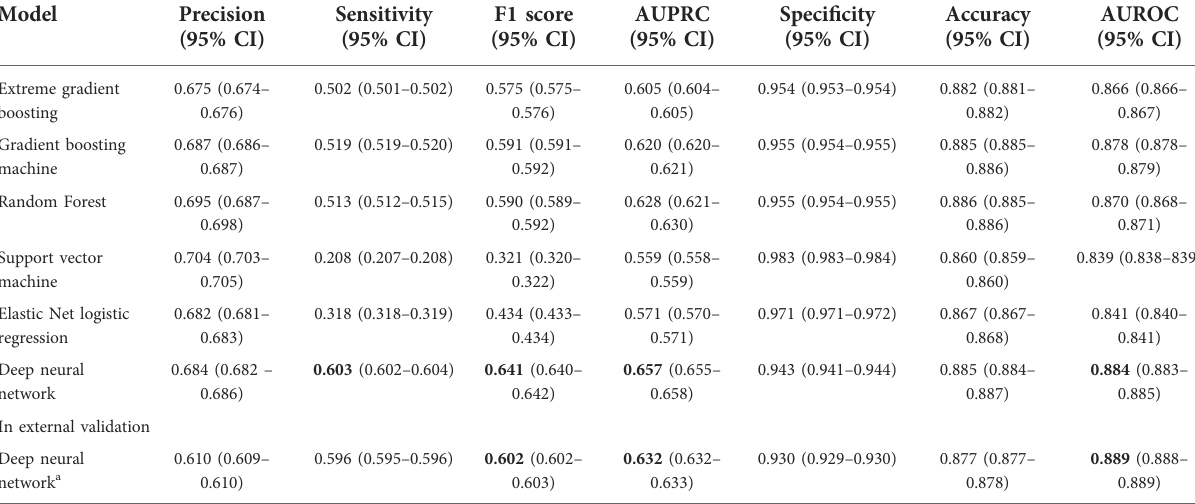
TABLE 1 Performance metrics of the deep neural network model and other machine learning models.